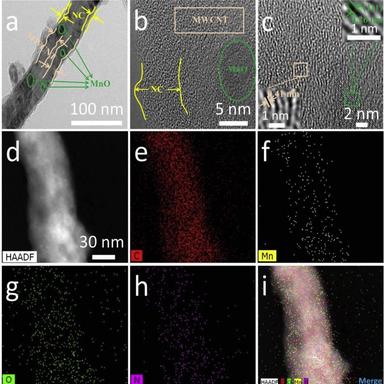
TEM (a, b), HRTEM (c) images (insets: the correlative fast Fourier transformed lattice fringe images), HAADF-STEM (d) image and corresponding elemental mapping (eei) images of CNT@MnO@NC.